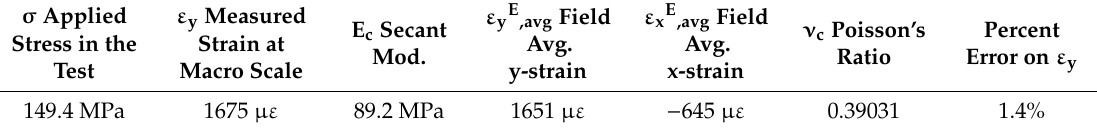
Figure 15. Trajectories of the principal strains in the representative volume element (RVE) of the Al–SiC composite specimen.